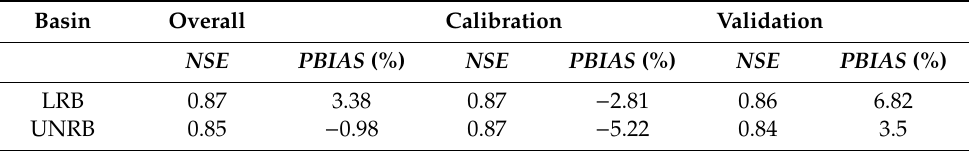
Table 4. Statistical indices for assessing performance of the